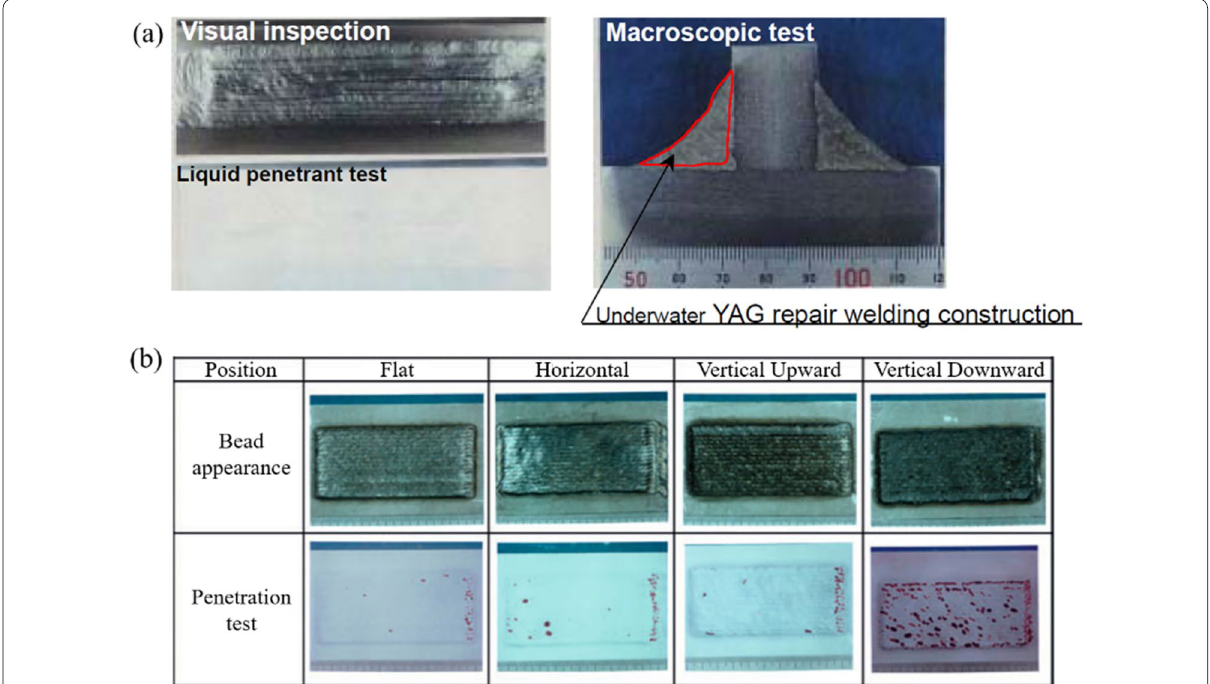
Figure 7 Results from IHI in Japan: ( a ) Visual inspection, liquid penetrant test and organization observation of Y308L coating by underwater Nd:YAG laser welding [35] and ( b ) bead appearance and penetration test of underwater Nd:YAG laser cladding for each position